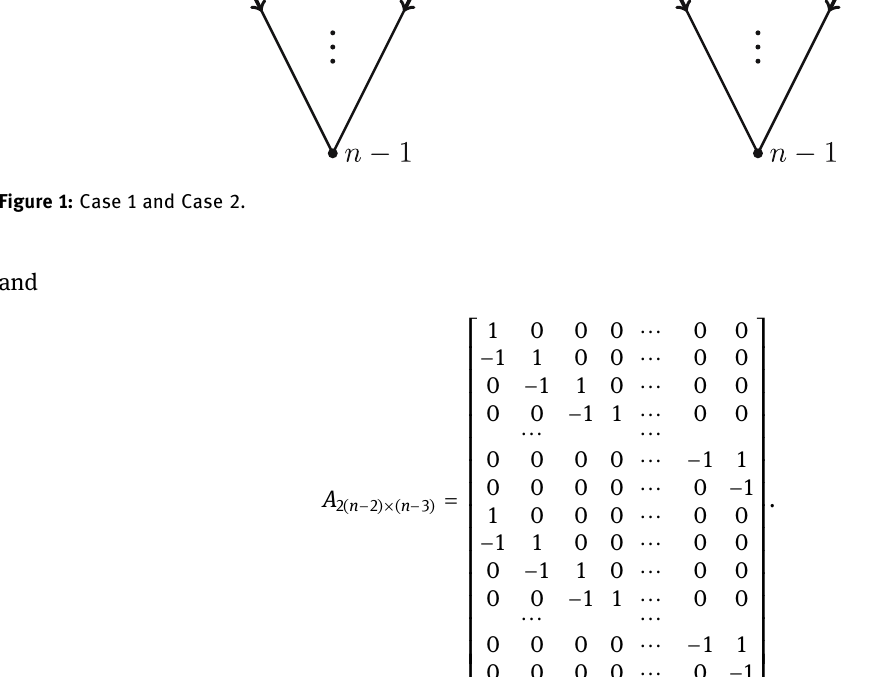
Figure 1: Case 1 and Case